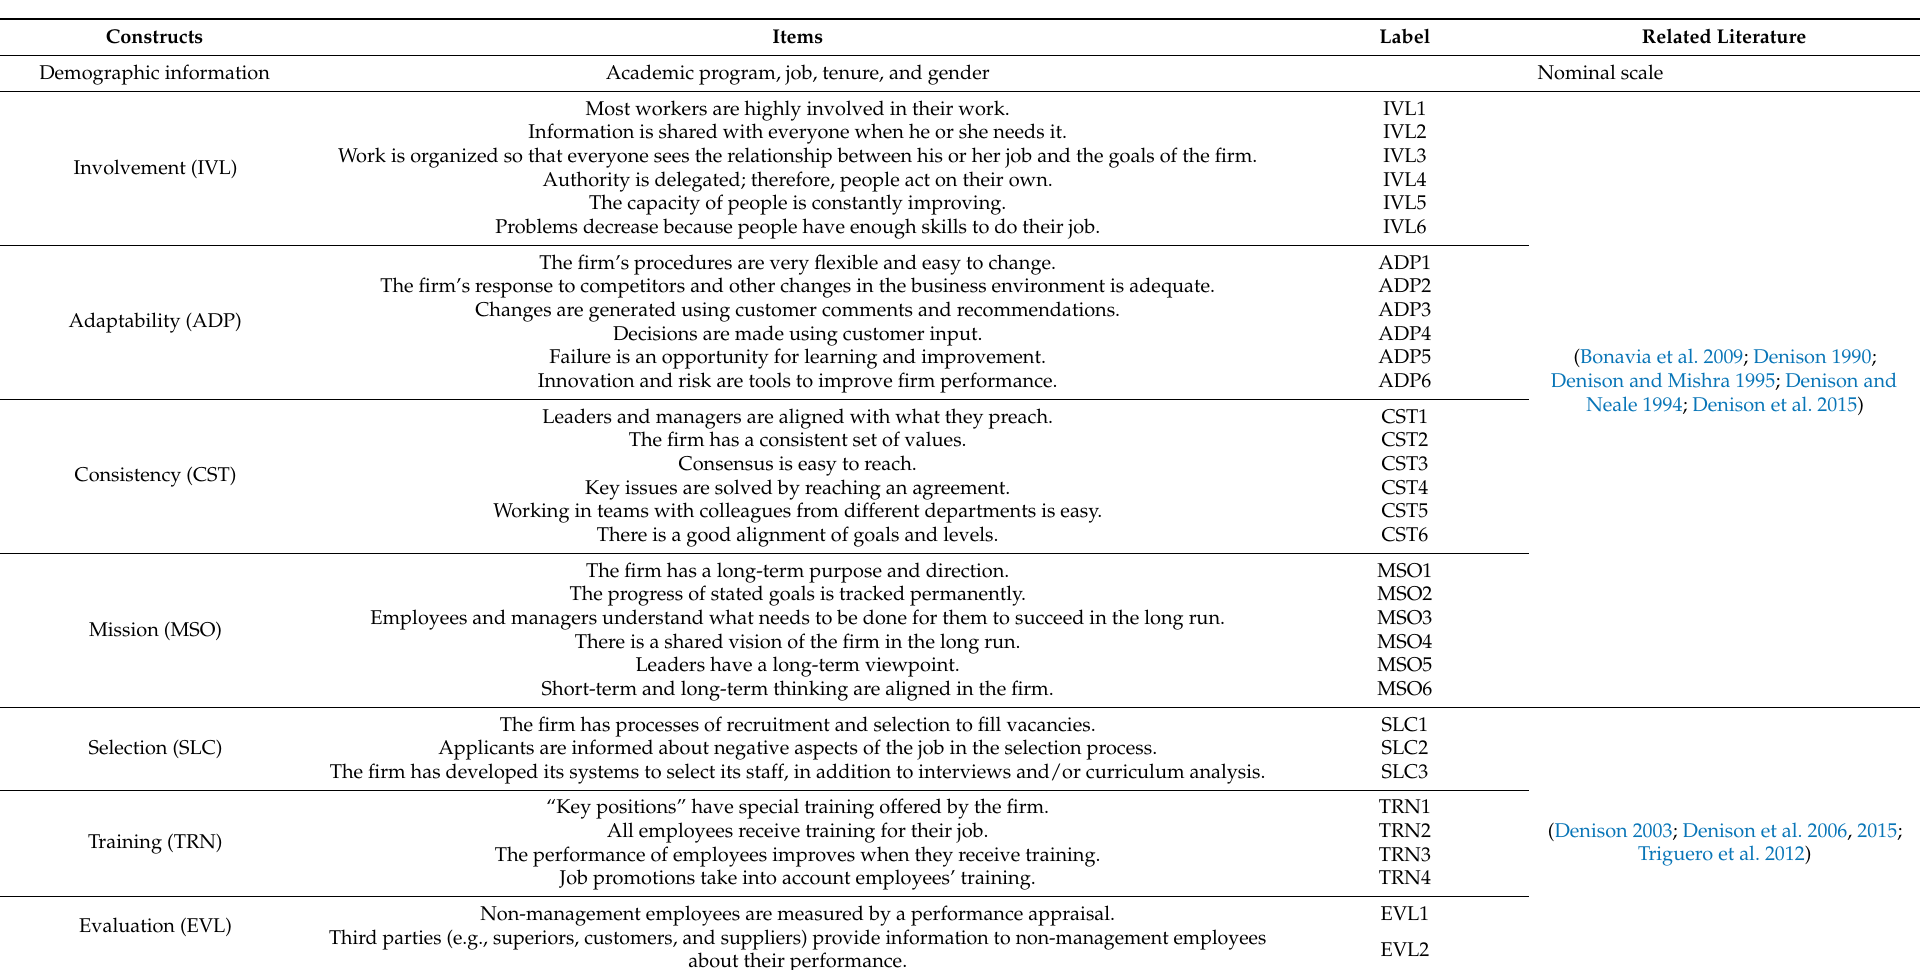
Table 1. Scale items for